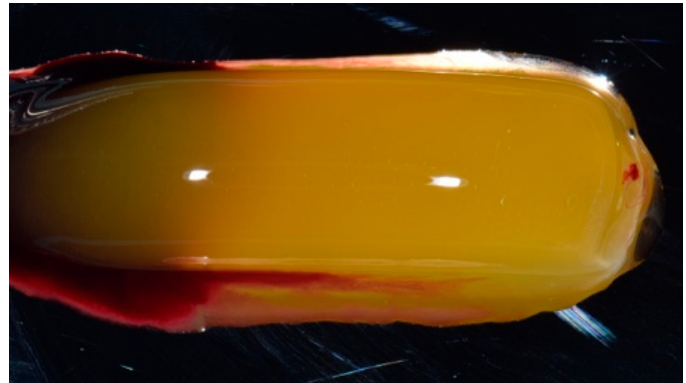
Figure 3. Platelet-rich fibrin (PRF) obtained from the patient’s blood sample.